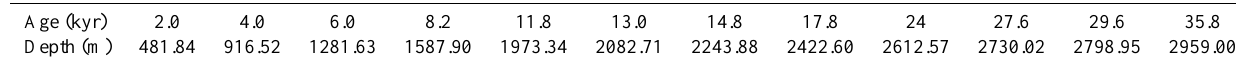
Table 1. Assumed depth–age tie points used for WAIS Divide.